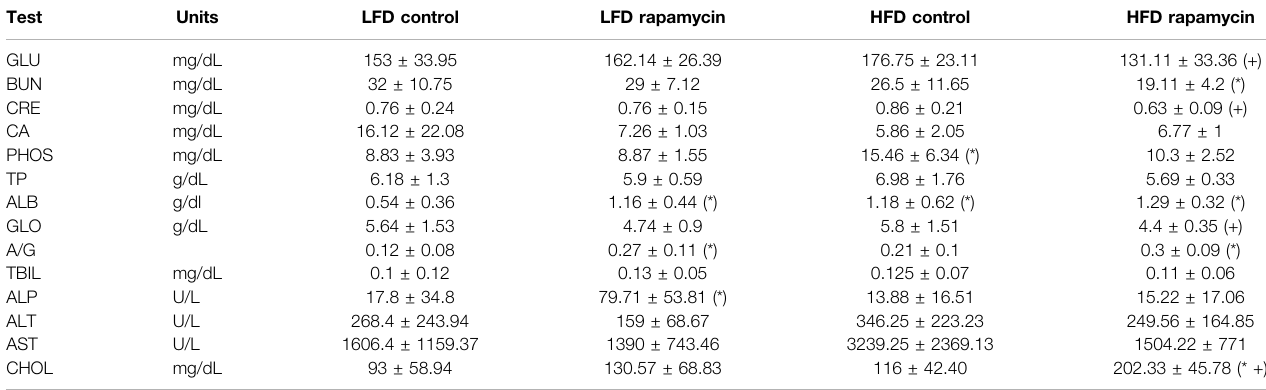
TABLE 1 | Serum metabolic panel at endpoint. GLU: Glucose. BUN: Blood Urea Nitrogen. CRE: Creatinine. CA: Calcium. PHOS: Phosphate. TP: Total Protein. ALB: Albumin. GLO: Globulin. A/G: Albumin/Globulin ratio. TBIL: Total Bilirubin. ALP: Alkaline Phosphatase. ALT: Alanine Transaminase. AST: Aspartate